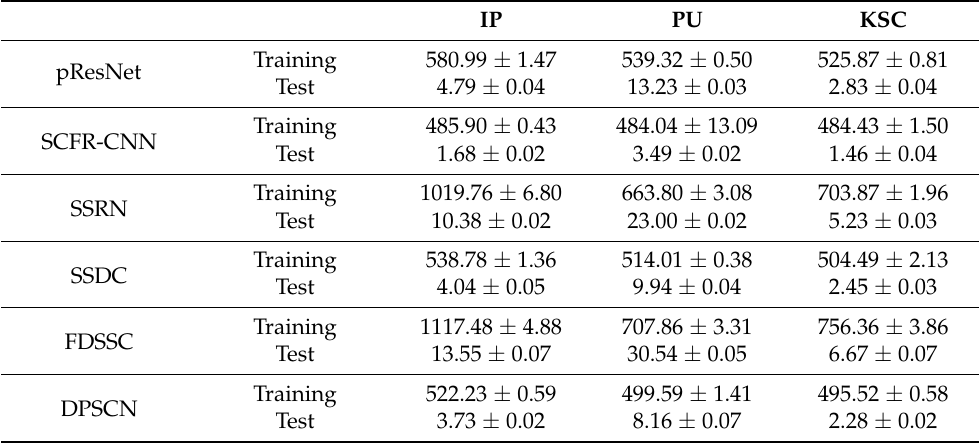
Table 9. Training and testing time (s) of the different models for three data sets. IP PU